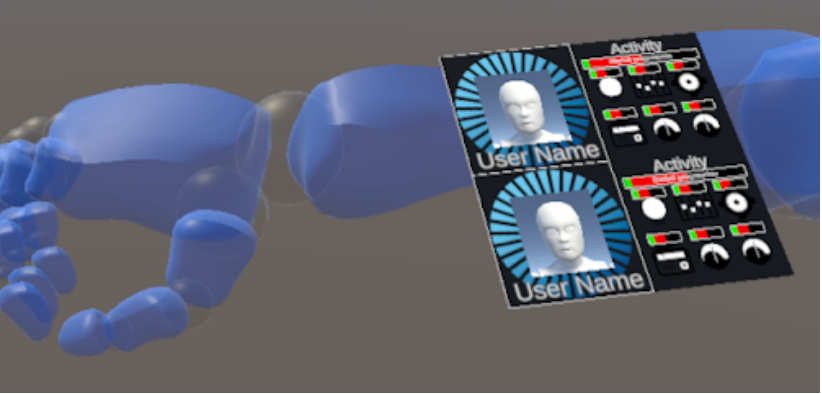
Figure 4. Body-relative placement: all information is on a panel attached to the avatar’s